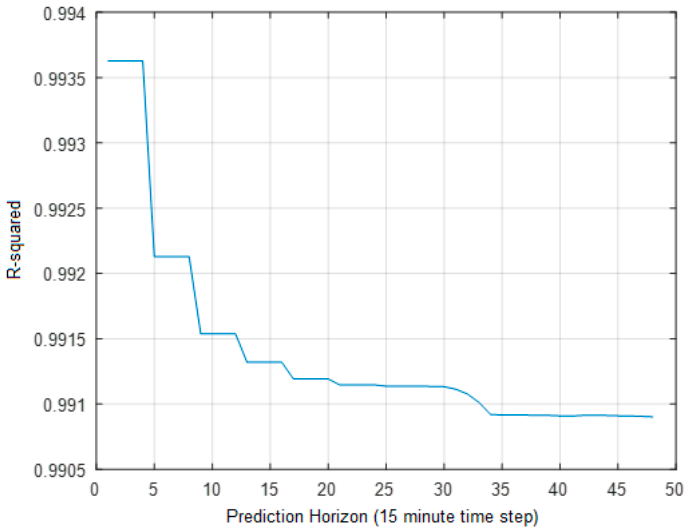
Figure 16. Coefficient of determination of the PV power within the prediction horizon.